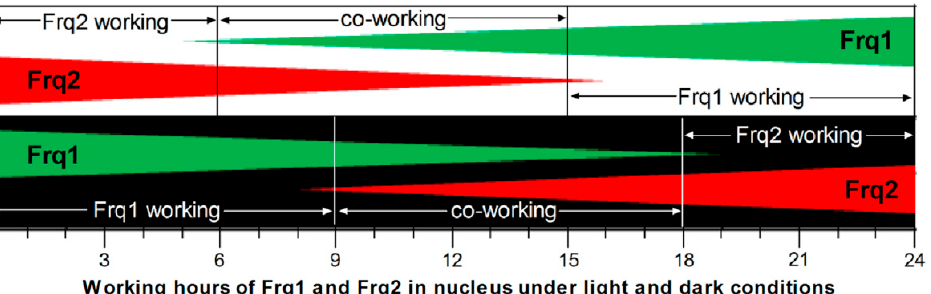
Figure 5. Proposed model for Frq1 and Frq2 to co-function in B. bassiana . ( A ) Possible changes in nuclear expression levels (rhythms) of Frq1 and Frq2 in a circadian day of different photoperiods. Nuclear and cytoplasmic accumulation levels of Frq1::GFP or Frq2::GFP in TS1 or TS2 and those of each fusion protein in the absence of the other frq (shown in Figure 2) were averaged on each sampling occasion during time-course exposure to light or dark. Error bar: SD of the mean from six replicates. ( B ) Dynamics of total FRQ (mean of Frq1 and Frq2) levels in nucleus and cytoplasm. Note that accumulation level of total FRQ in nucleus fluctuates in a narrow range and is most stable at the median time point (arrowed) of a circadian day irrespective of photoperiod change. Error bar: standard error (nuclear) or SD (cytoplamic) of the mean from 12 replicates. ( C ) Proposed model for Frq1 and Frq2 to function on alternate duty in the nucleus in the presence of FRH. Either Frq1 or Frq2 works alone for a period, co-works with the other for another period, and then disappears in nucleus irrespective of a day beginning from daytime or nighttime.